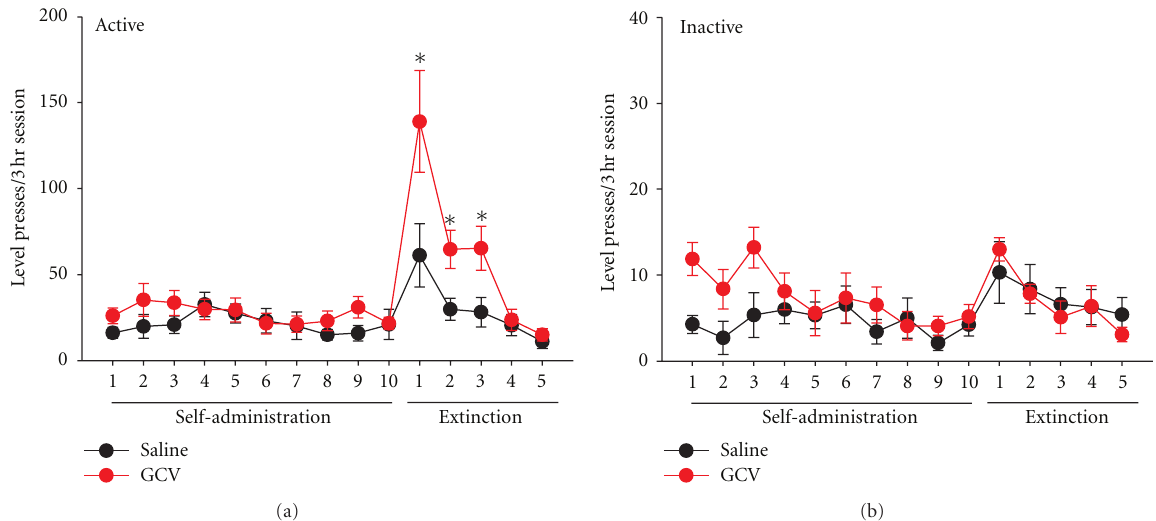
Figure 3: Heroin self-administration and extinction in GFAP-tk mice implanted with minipumps containing either saline or GCV. (a) Active lever presses during 10 days of heroin self-administration followed by 5 days of extinction. Mice treated with GCV ( n = 11) displayed increased extinction responding during the first 3 extinction days (E1–E3) as compared to mice that were treated with saline ( n = 9). ∗ P < 0 . 05 versus saline-treated mice on the same day of extinction. (b) Inactive lever presses during 10 days of heroin self-administration followed by 5 days of